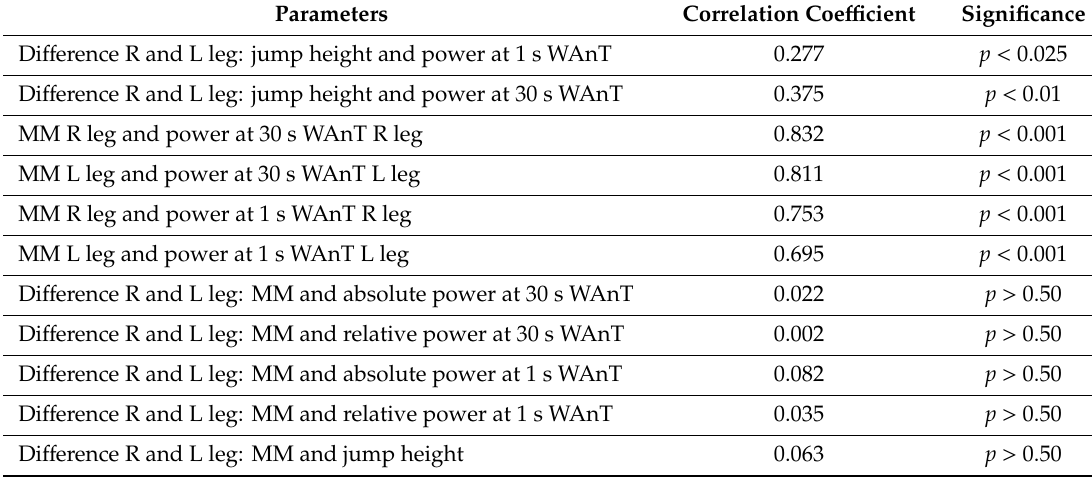
Table 2. Relationship between the individual variables.